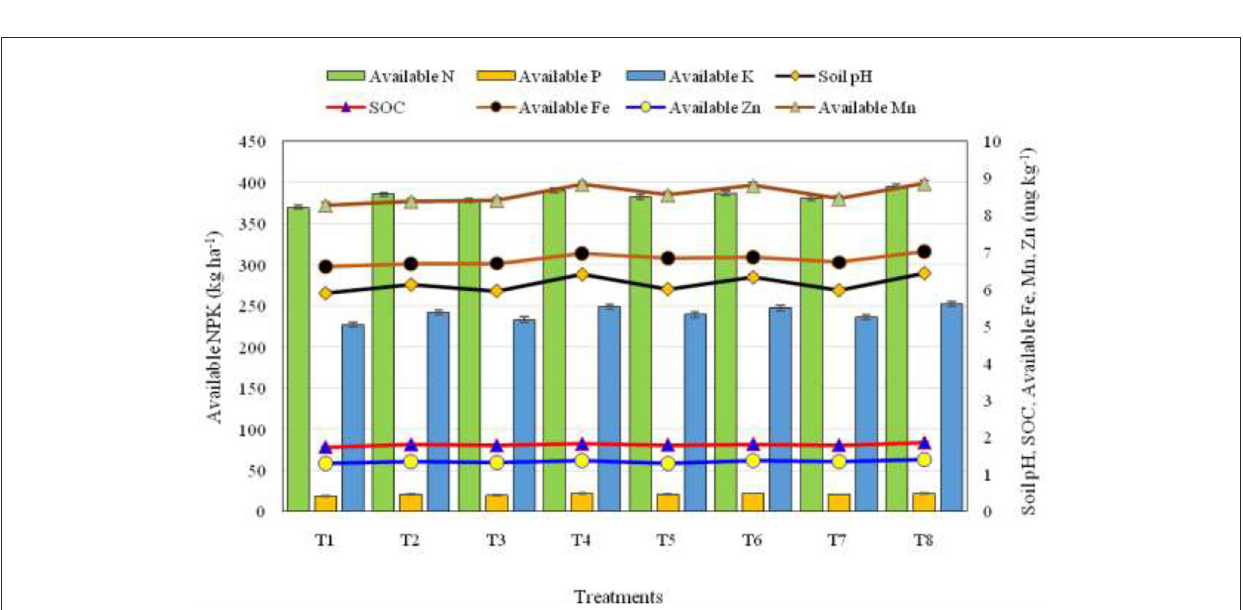
FIGURE4 Effect of the conjoint application of different organic sources of nutrients on the chemical properties of the soil after completion of the two years cropping system. SOC, soil organic carbon (%); T1—farmers’ practice (FYM ∼ 50% RDN); T2—100% RDN through FYM; T3—100% RDN through mixed compost (MC); T4—100% RDN through vermicompost (VC); T5—50% RDN through FYM + 50% RDN through MC; T6—50% RDN through FYM + 50% RDN through VC; T7—50% RDN through MC + 50% RDN through VC; T8—33% RDN through FYM + 33% RDN through MC + 33% RDN through